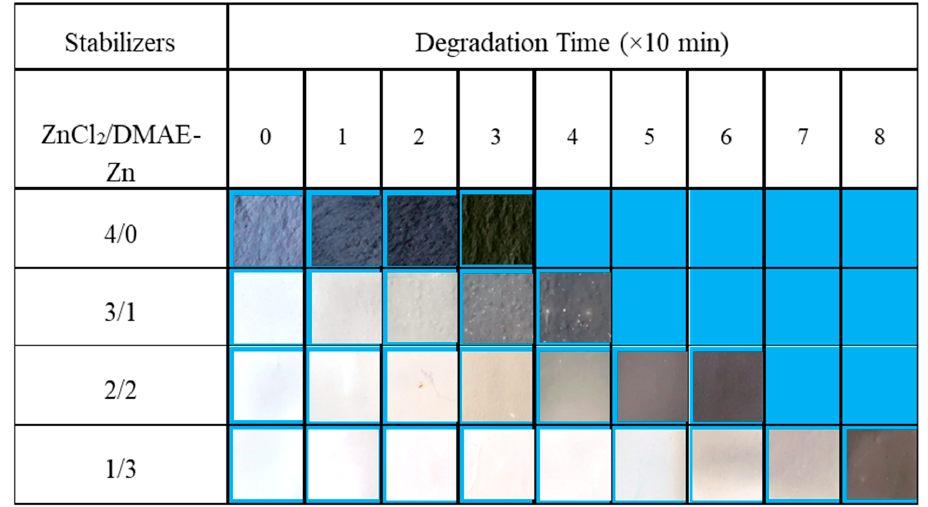
Figure 9. Color evolution of PVC samples with different ratios of ZnCl 2 and DMAE-Zn heated at 180 °C for different periods of time.